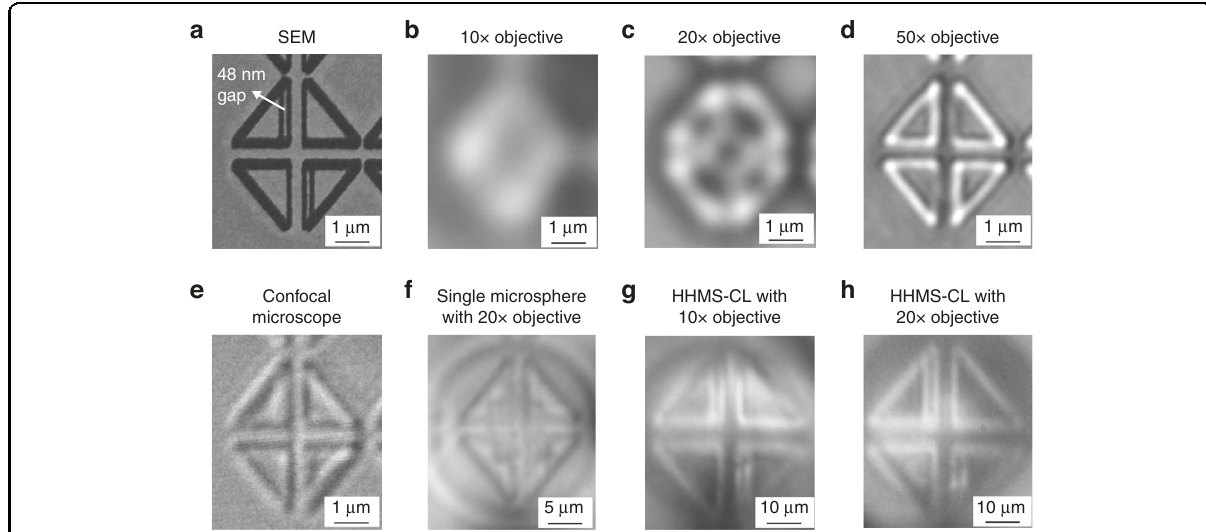
Fig. 6 Imaging comparisons among different optical microscopy techniques. A rhombus-shaped pattern with ~48 nm gap is imaged by ( a ) SEM, b – d conventional optical microscope with 10×, 20× and 50× objective lenses, e confocal microscope, f single borosilicate glass microsphere nanoscope, g , h HHMS-CL coupled with 10× and 20× objective lenses, respectively